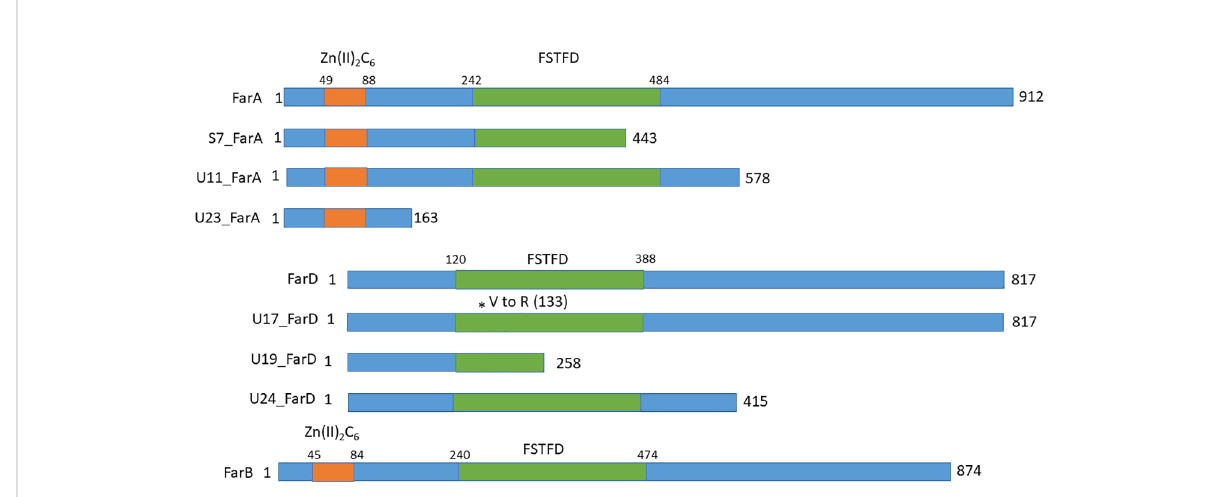
FIGURE 5 Schematic overview of the domains and the positions of nonsense mutations in FarA, FarD and FarB identi fi ed in the fl uoro-acetamide resistant mutants. The Zn(II)2Cys6 binding domain in FarA and FarB are indicated by the orange box and the Fungal Speci fi c Transcription Factor Domain (FSTFD) is indicated in green. * indicates the position of the